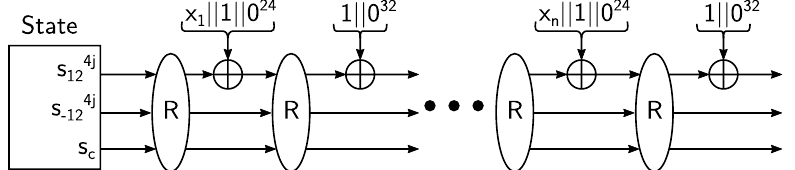
Figure 5: Subterranean absorb with operation unkeyed.